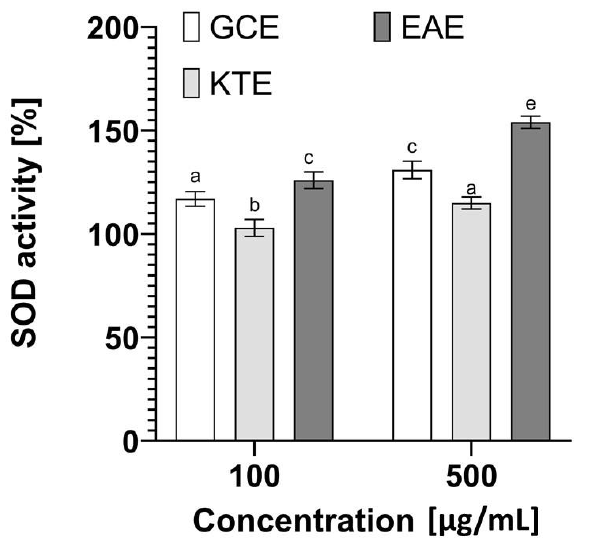
Figure 10. Effect of Centella asiatica L. (GCE), Clitoria ternatea L. (KTE) and Epilobium angustifolium L. ( EAE ) extracts on superoxide dismutase activity. Data are the mean ± SD of three independent experiments, in which each concentration was tested in duplicate. Different letters on the charts indicate significant differences between groups ( p < 0.05).